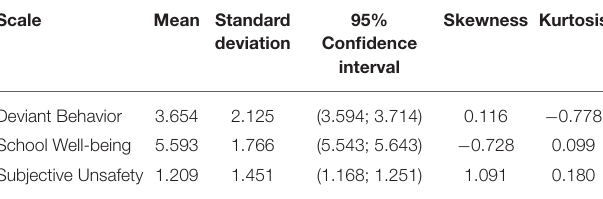
TABLE 1 | Descriptive statistics of the